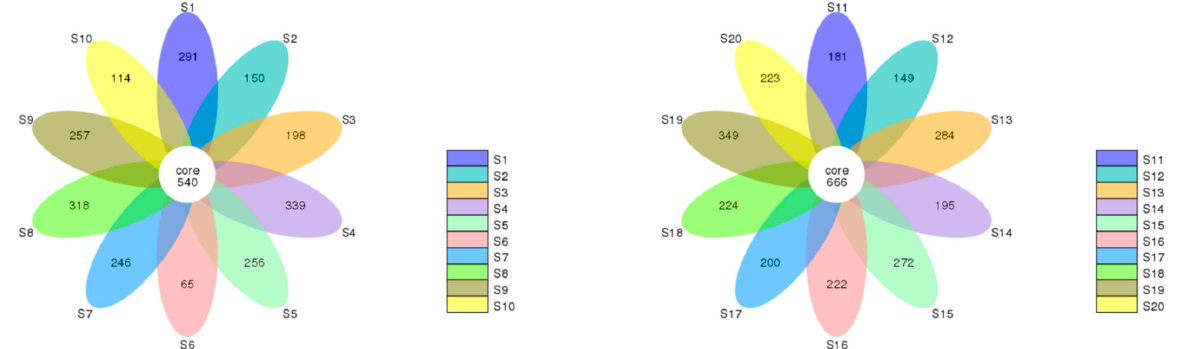
Figure 6. The monsoon (left) and dry season (right) operational taxonomic units (OTUs) are depicted in the flower diagram (right). A sample or group is represented by each petal in the floral diagram, with various colours denoting various samples or groups. The core number in the middle represents the total number of OTUs present across all samples, whereas the petal number represents the total number of distinct OTUs present across all samples.